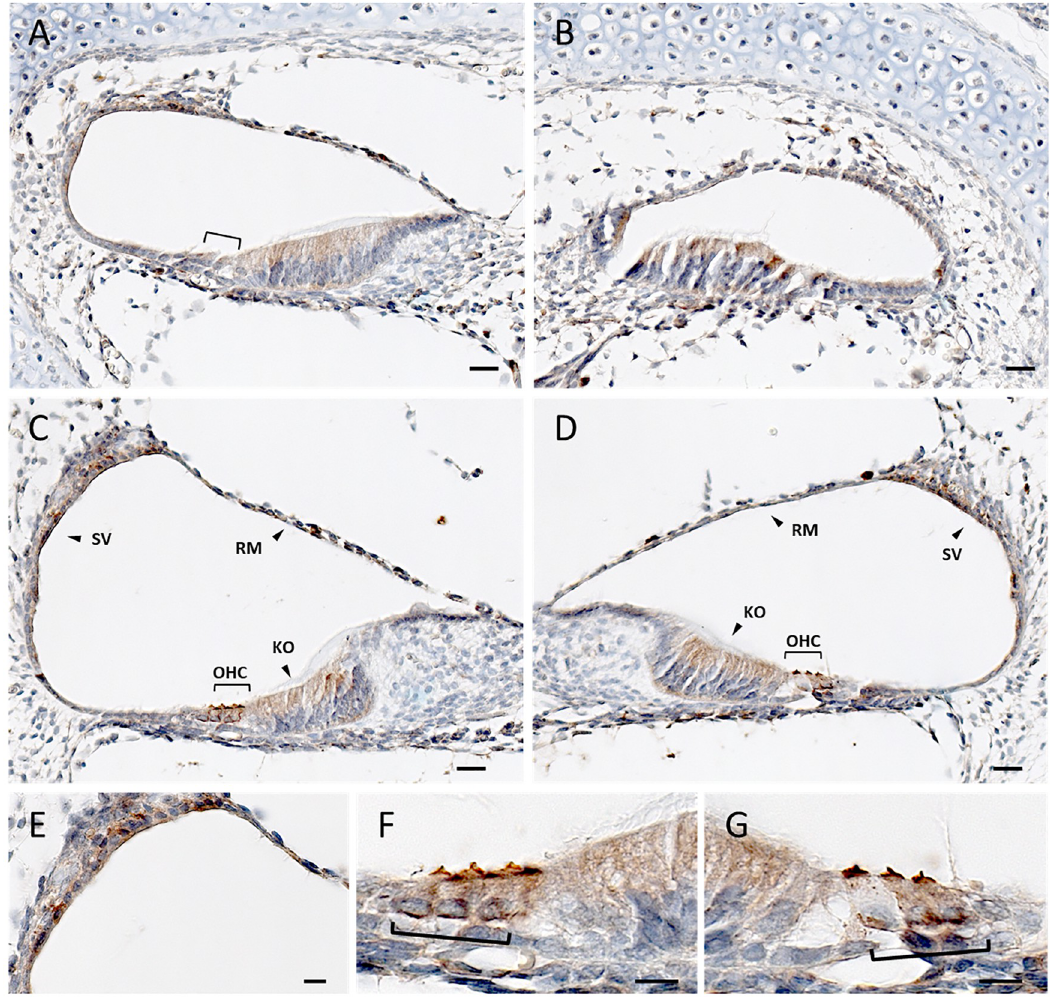
Fig 3. Diaph2 expression in P0 wild-type mouse cochlea. Brown indicates positive staining. ( A-D ) Cross section of the cochlear turns (B: apical, A, D: mid, C: basal turn) of a P0 wild-type mouse. At this stage, a different degree of cell differentiation can be observed from the base to the apex. The square brackets indicate OHCs (outer hair cells). The arrowheads indicate: Ko¨lliker’s organ (KO), Reissner’s membrane (RM), stria vascularis (SV). Dorsal to the bottom. ( E ) Higher magnification of the stria vascularis in C. ( F-G ) Higher magnification of the OHC shown, respectively, in C and D. Scale bar: 10 μ